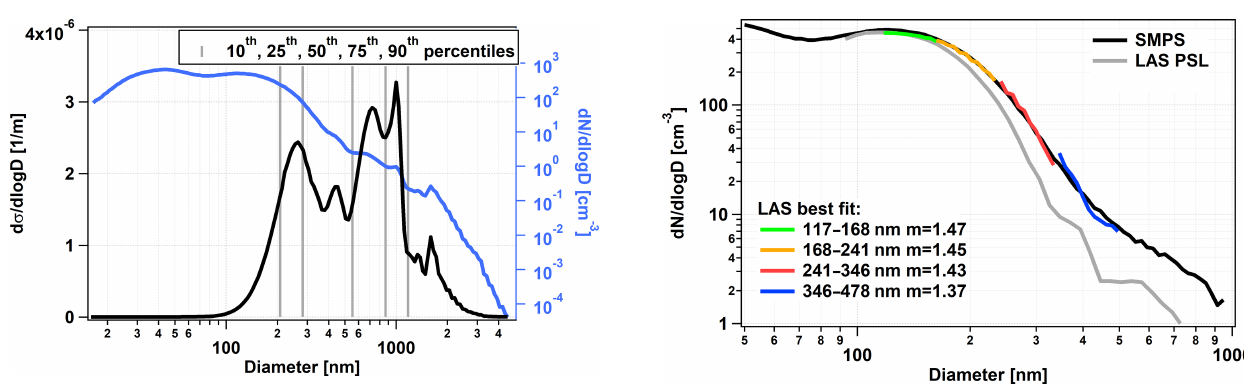
Figure 10. The average dry aerosol number size distribution mea- surements during December 2017 and January 2018 as measured by the SMPS (black line) and the LAS (gray line). The colored lines show the four individual RI fits using four different particle size